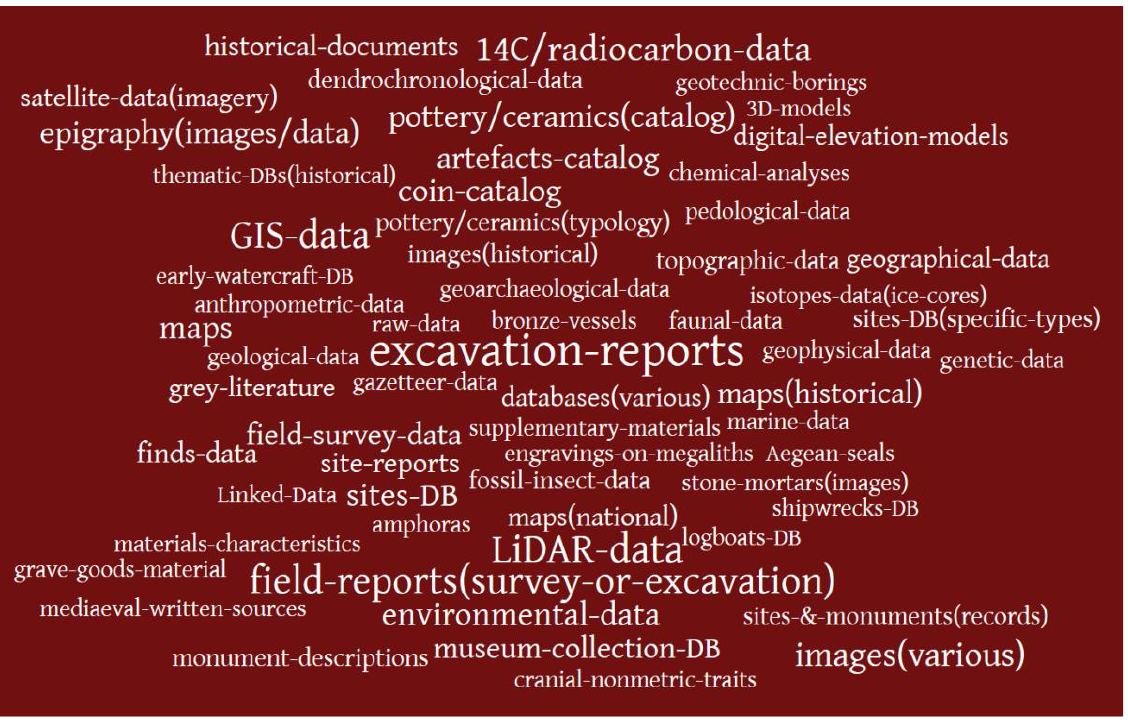
Figure 4 : Word cloud of 50+ types of data, data sources and specific research